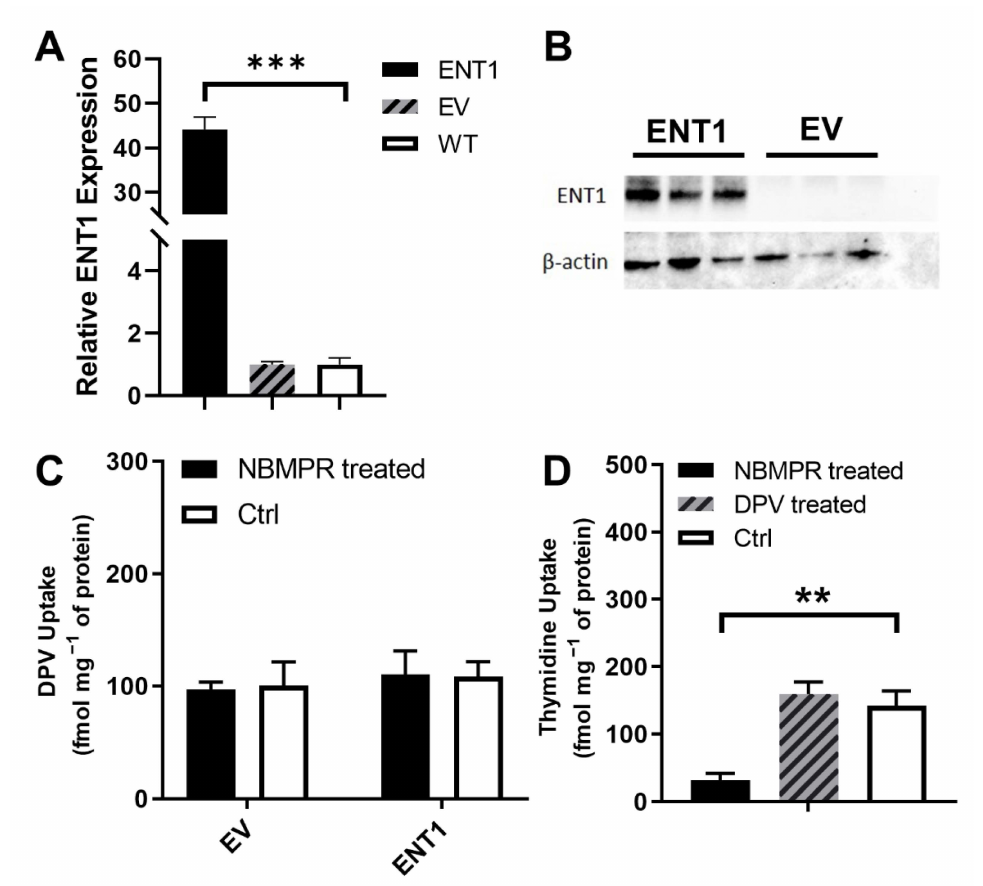
Figure 5. ( A ) Relative expression of ENT1 from HEK293 cells at mRNA level, *** p < 0.001 compared to WT; ( B ) Expression of ENT1 at protein level; ( C ) Normalized cellular uptake of DPV in HEK293 ENT1 and EV cells with and without nitrobenzylthioinosine (NBMPR and Ctrl) ( n = 3); ( D ) Normalized cellular uptake of thymidine in HEK293 ENT1 cells treated with nitrobenzylthioinosine, DPV, or blank buffer (NBMPR, DPV, or Ctrl). Data represented as mean ± SD of three biological replicates. ** p < 0.01 in comparison to no drug treatment (Student’s t